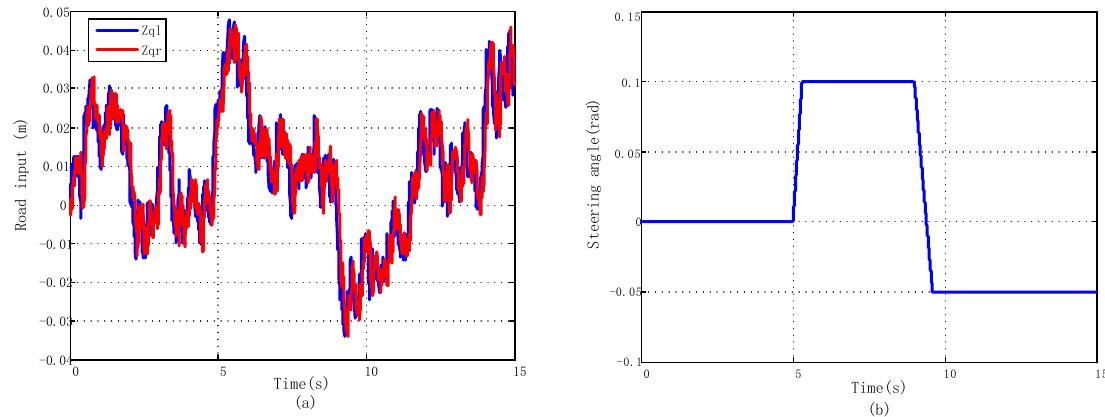
Figure 22. The input signals of vehicle: ( a ) the random road; ( b ) the steering angle under the fishhook maneuver. The dynamic responses of the HDSMC-controlled vehicle (blue lines), RCSMC-controlled vehicle (black lines), and the vehicle with the Switched SMC (red lines) are shown in Figure 23.